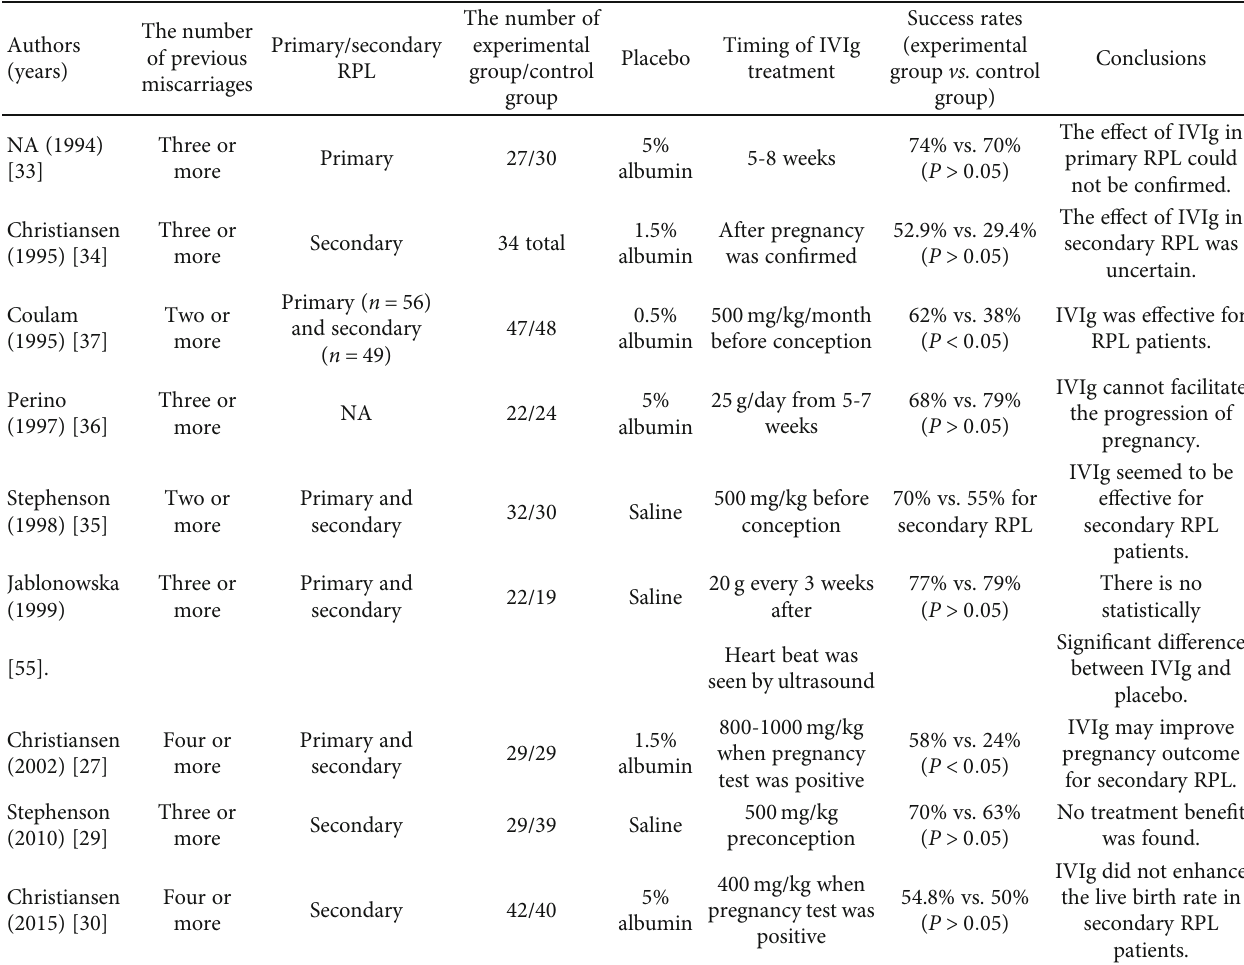
Table 2: Randomized controlled trials (RCTs) of intravenous immunoglobulin (IVIg) in women with unexplained recurrent pregnancy loss (RPL).